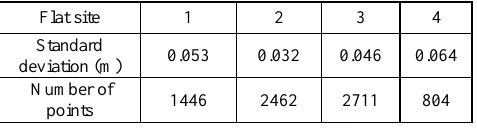
Table 1. Standard deviations of flat plane